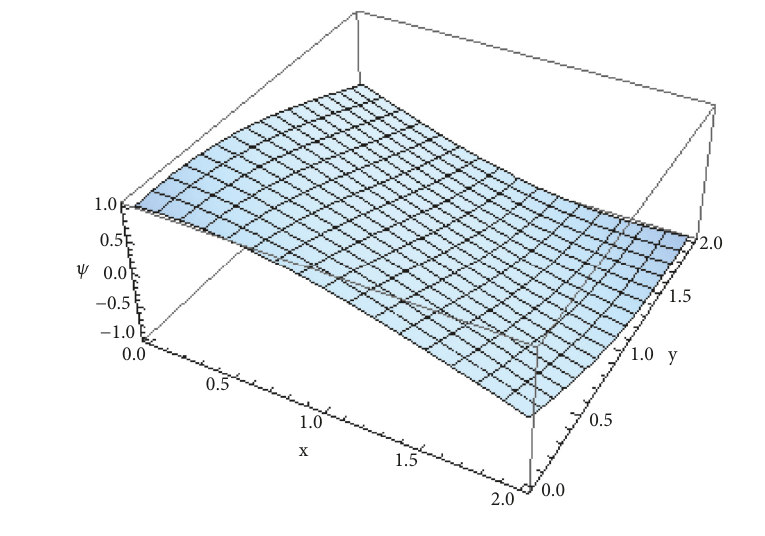
Figure 5: Real solution of the two-dimensional wave function obtained by LADM and HPM.